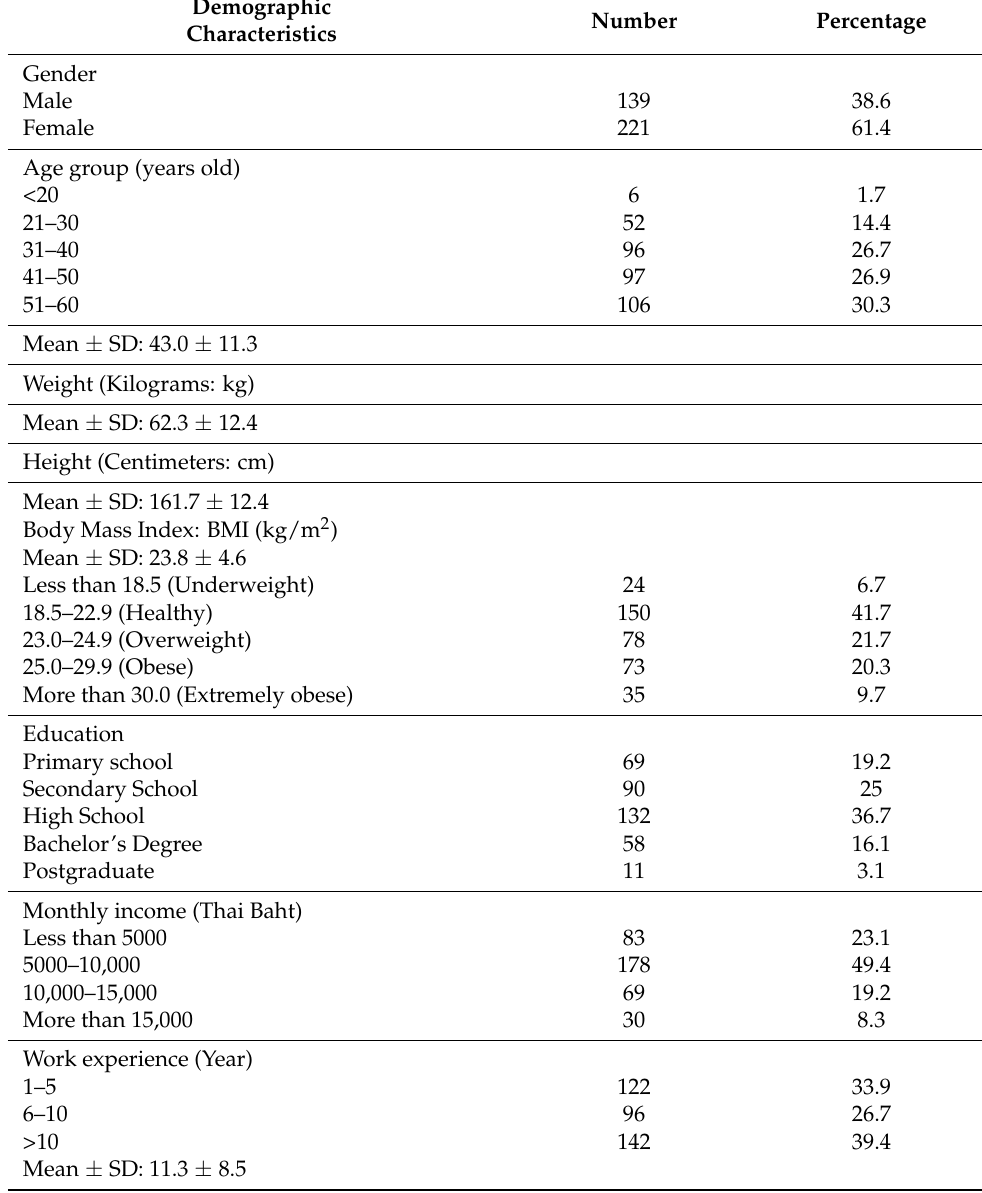
Table 1. Demographic information and socio-demographic of the respondents ( n =